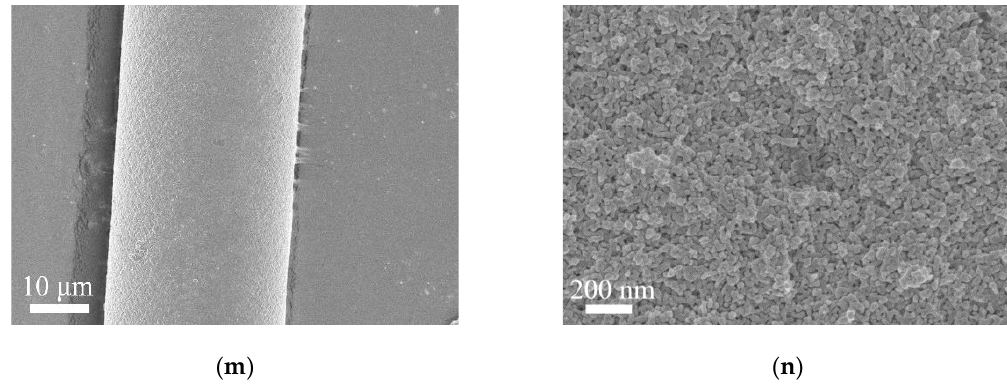
Figure 8. The morphology and cross-section microstructure of calcined Al 2 O 3 fibers: ( a , b ) Sample-A1; ( c , d ) Sample-A2; ( e , f ) Sample-A3; ( g , h ) Sample-A4; ( i , j ) Sample-A5; ( k , l ) Sample-B1; ( m , n ) Sample-B2.